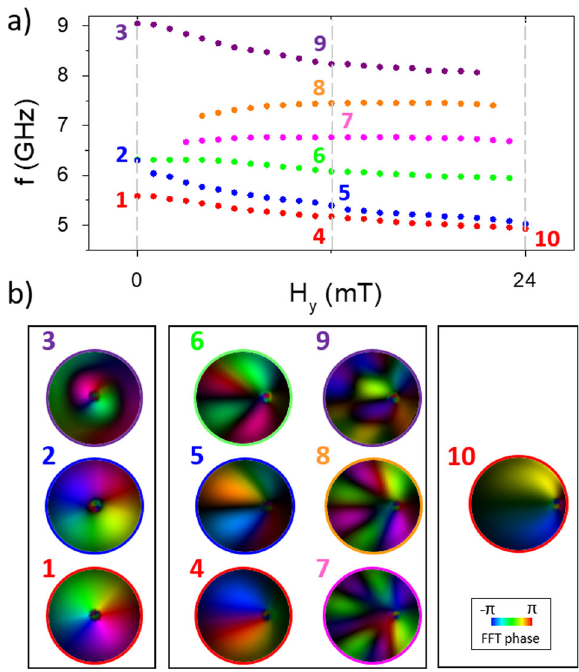
Fig. 3 Higher-order mode fi eld dependence. a In-plane fi eld, H y , dependence of the various spin-wave mode frequencies, f , present in the nanopillar calculated with micromagnetic simulations and b bivariate fast Fourier transform (FFT) phase and amplitude images at selected frequencies and fi eld.